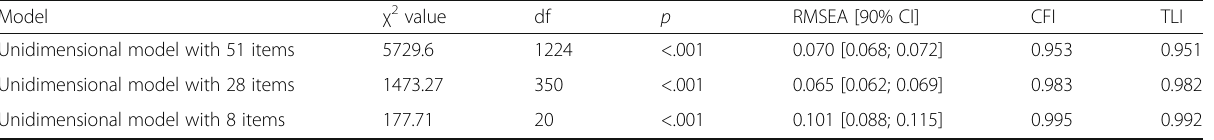
a WLSMV: robust weighted least squares b Sample size for the models with 51, 28 and 8 items, respectively, was